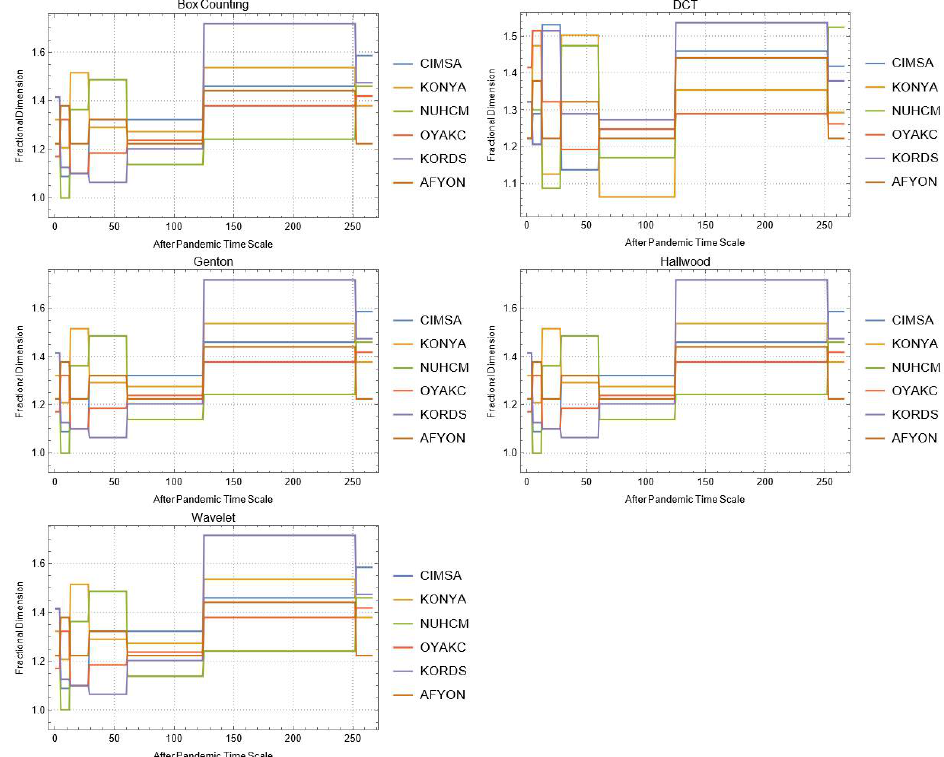
Figure A21. Daily changes of fractal dimensions after the pandemic (machineries).